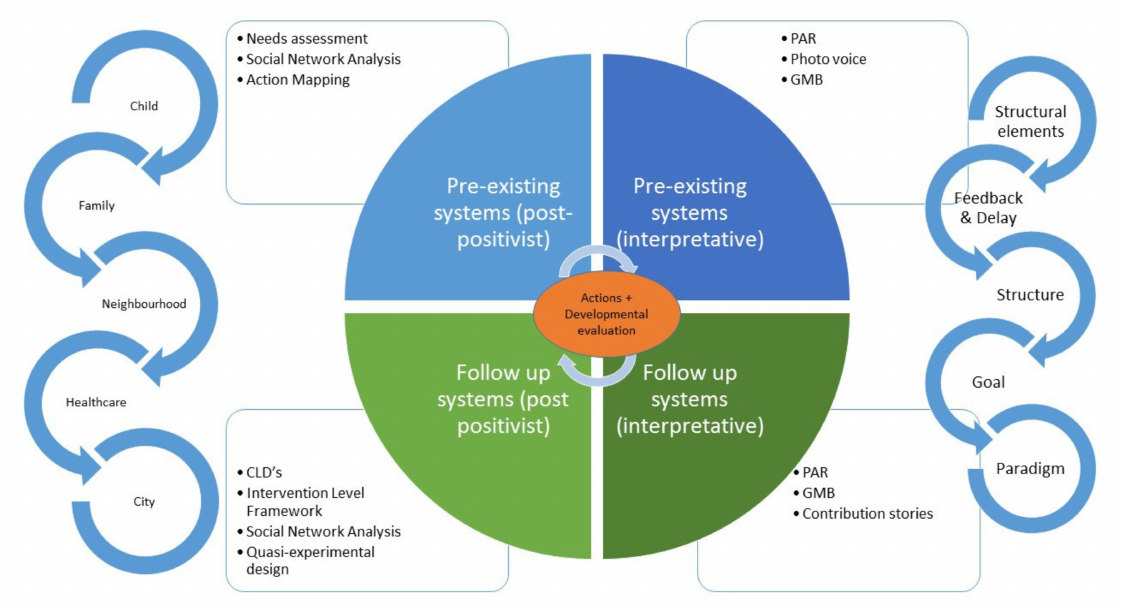
Figure 1. Overview of the di ff erent components of the LIKE programme and how they relate to each other. PAR = Participatory Action Research. GMB = Group Model Building. CLD = Causal Loop